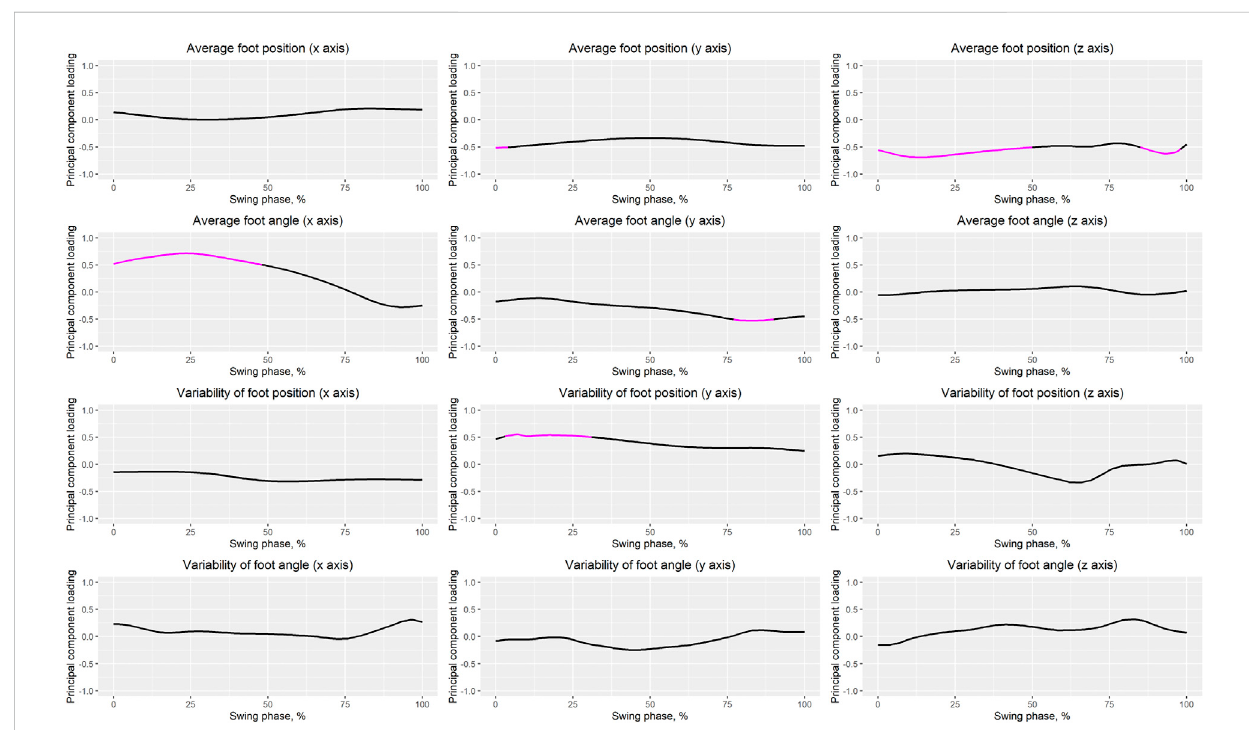
FIGURE 4 Waveforms of PCLs. The magenta solid line indicates that the absolute value of the PCL is greater than